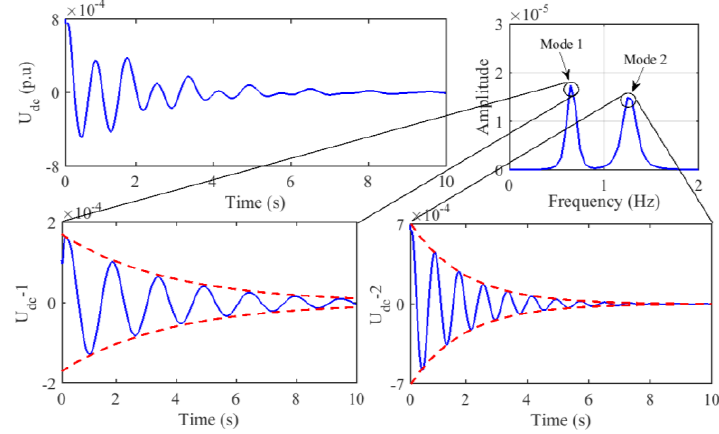
Figure 11. Time domain trajectory of DC voltage of GVSC.